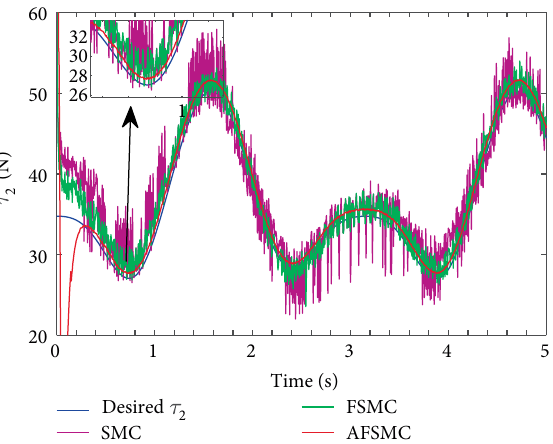
Figure 20: The boxplot of parameter